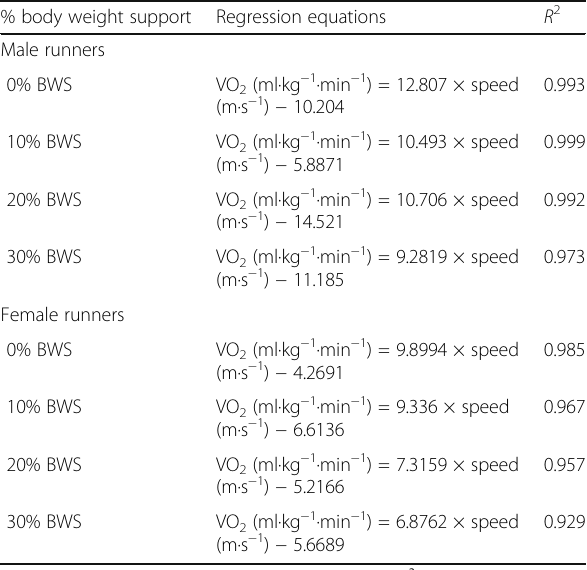
Table 6 Equations from linear regression analyses defining oxygen consumption (VO 2 ml·kg − 1 ·min − 1 ) as functions of running speed (m·s − 1 ) at each BWS for male and female runners % body weight support Regression